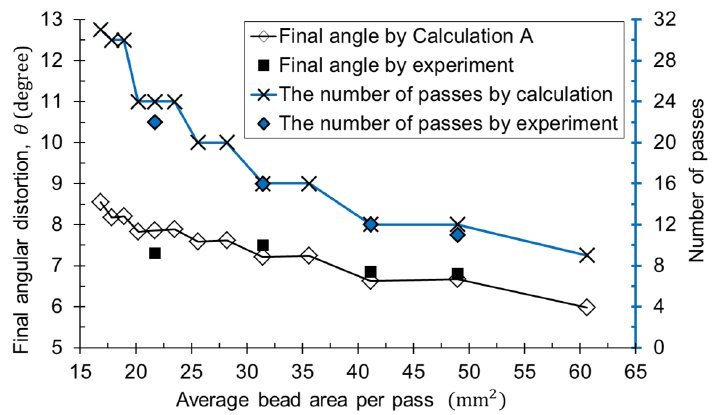
Figure 14. Final angular distortion with different bead areas per pass and the number of passes.